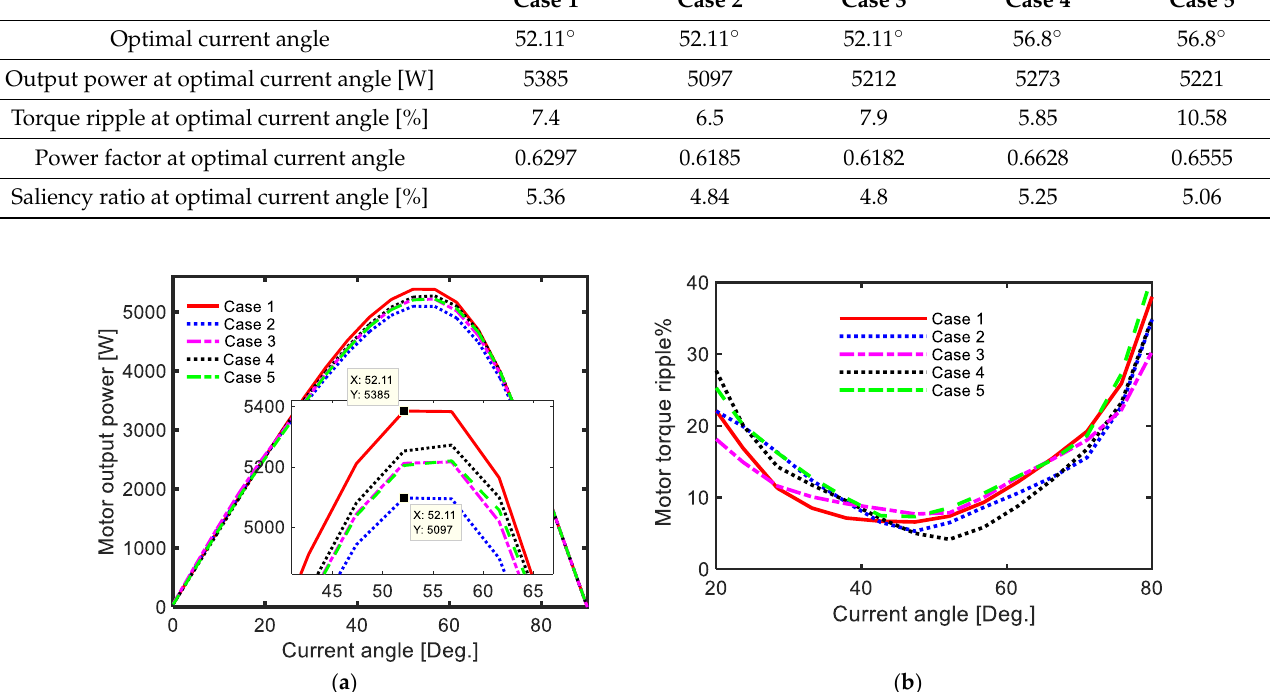
Figure 11. ( a ) Motor output power and ( b ) torque ripple at different current angles and at rated conditions for the optimal geometry of different cases.